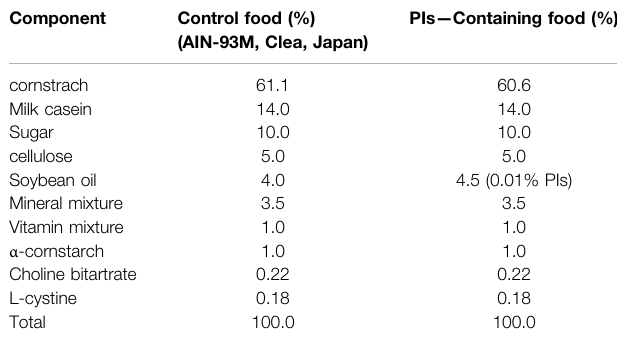
TABLE1| ThefattyacidcompositionofthePls-Etninthepuri fi edPlsfromchicken (cPls) and scallop (sPls). Fatty acid sPIs (% w/w)